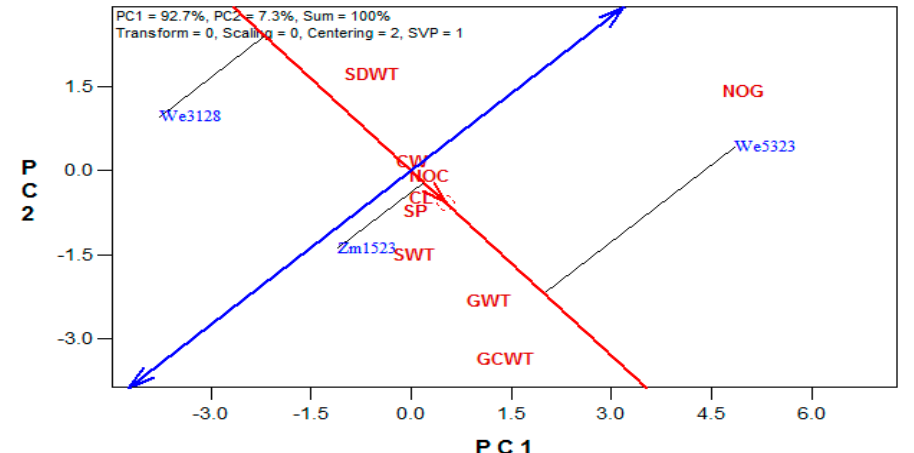
Figure 1. The mean performance vs. stability view of the three maize varieties (NOC = cob number, CL = cob length (cm), CW = cob width (mm), GCWT = cob weight (g plant − 1 ), GWT = grain weight (g plant − 1 ), NOG = grain number, SP = shelling percentage (%), SWT = 100-seed weight (g plant − 1 ), and SDWT = stover dry weight (g plant − 1 )).